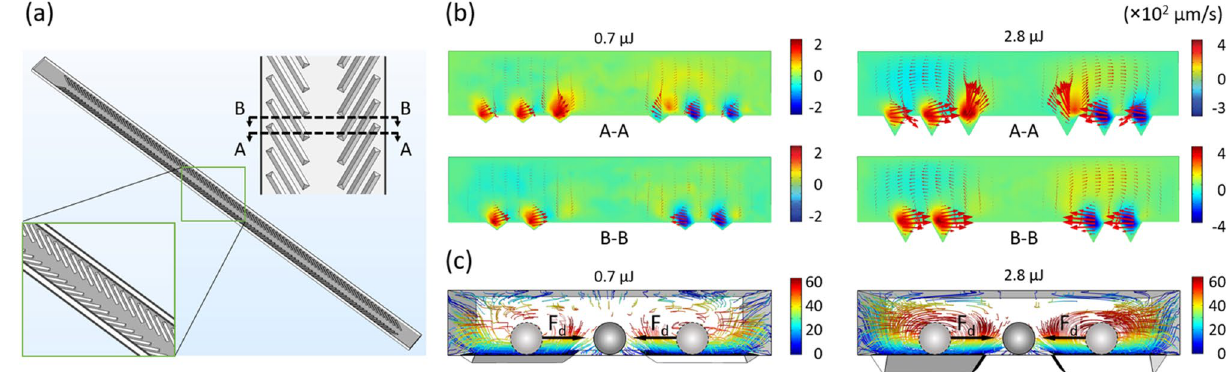
Figure 3. Numerical analysis of flow fields for particle focusing in a microchannel with fs laser patterned grooves. ( a ) 3D structure of the microchannel used in the simulation. The insets are enlarged views of the grooves. ( b ) 2D vector plots of flow velocity fields at cross-sections of the microchannel. Red arrows are scalars shown in a proportional way. ( c ) Front view of the channel with 3D flow streamlines with schematic illustrations of expected particle lateral displacements according to ( b ) for non-buoyant particles. (We used the software COMSOL Multiphysics 5.4 to create the image).